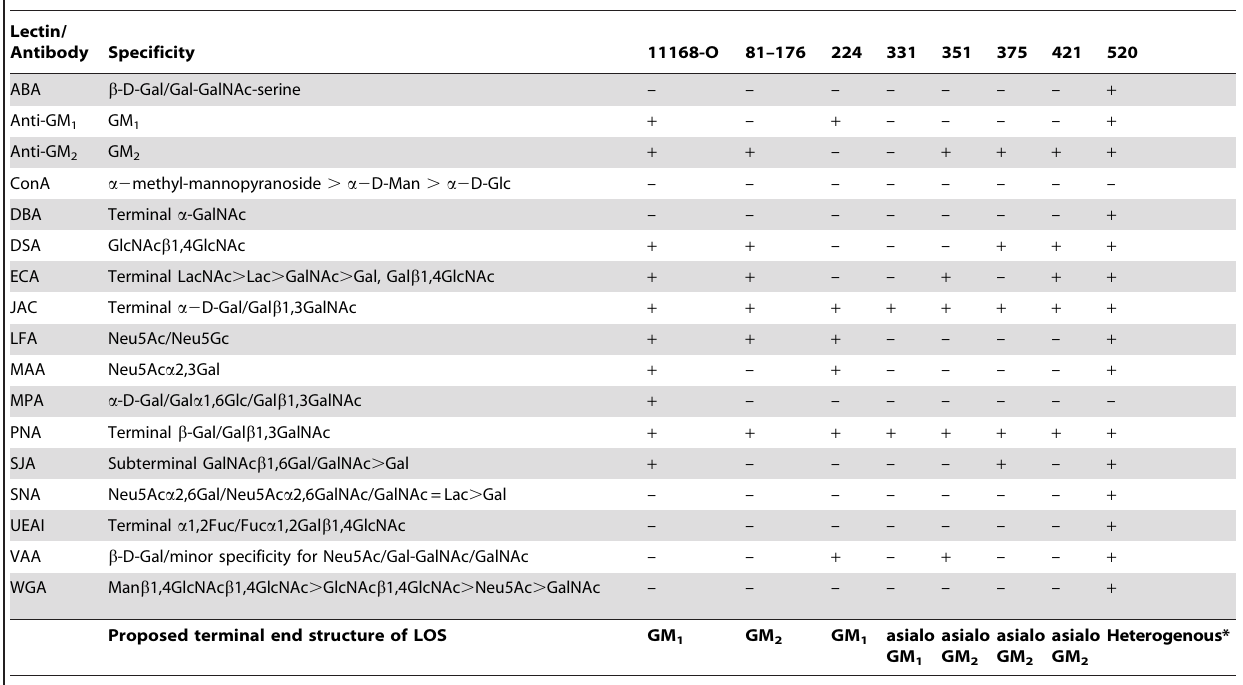
Table 2. Lectin array